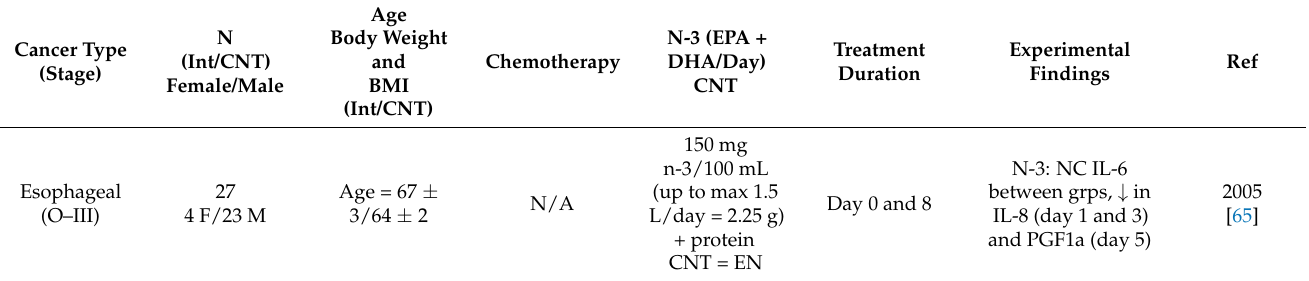
Table 4. Randomized controlled trials providing N-3 enteral or parenteral